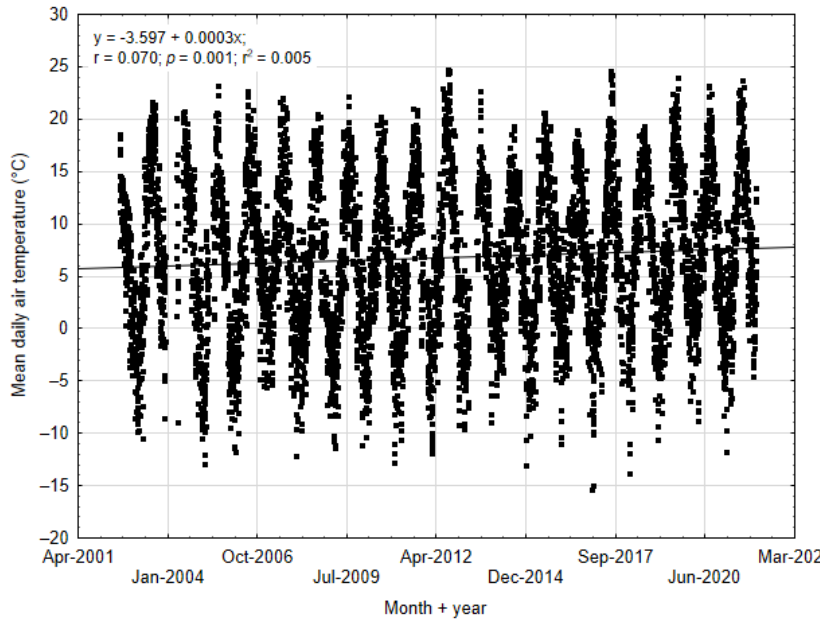
Figure 4. Trend over time of air temperature from 2002 to 2021. Data from Sibilla Mountain meteorological station.